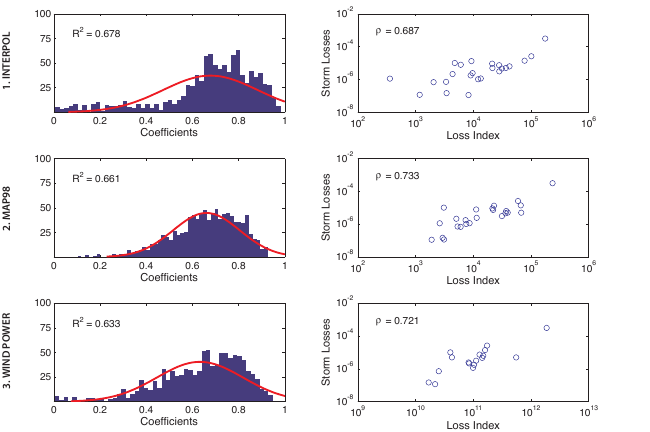
Fig. 4. Model results for the confined zone are plotted for the 3 methods: INTERPOL (top), MAP98 (middle) and WIND POWER (bottom). Left: the bootstrap results, with histograms of the determination coefficients values for the 1000 samples of the bootstrap. Mean values are shown on the graphs. Right: scatter- graphs, with calculated loss indices on the abscissas and observa- tions on the ordinates (loss ratios, expressed in CHF 0.01 per CHF 1000 insured). All scales are log scales. The Spearman’s rank cor- relation coefficients ( ρ) are